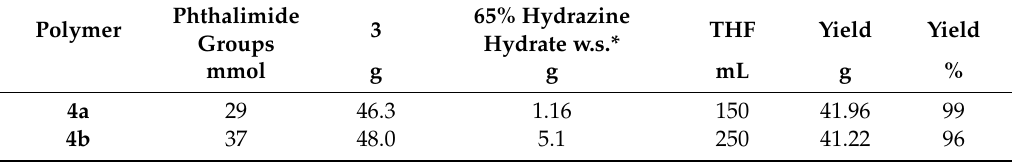
Table 4. Amounts of reagents used for the reaction of hydrosililation of 3 and the reaction yields.